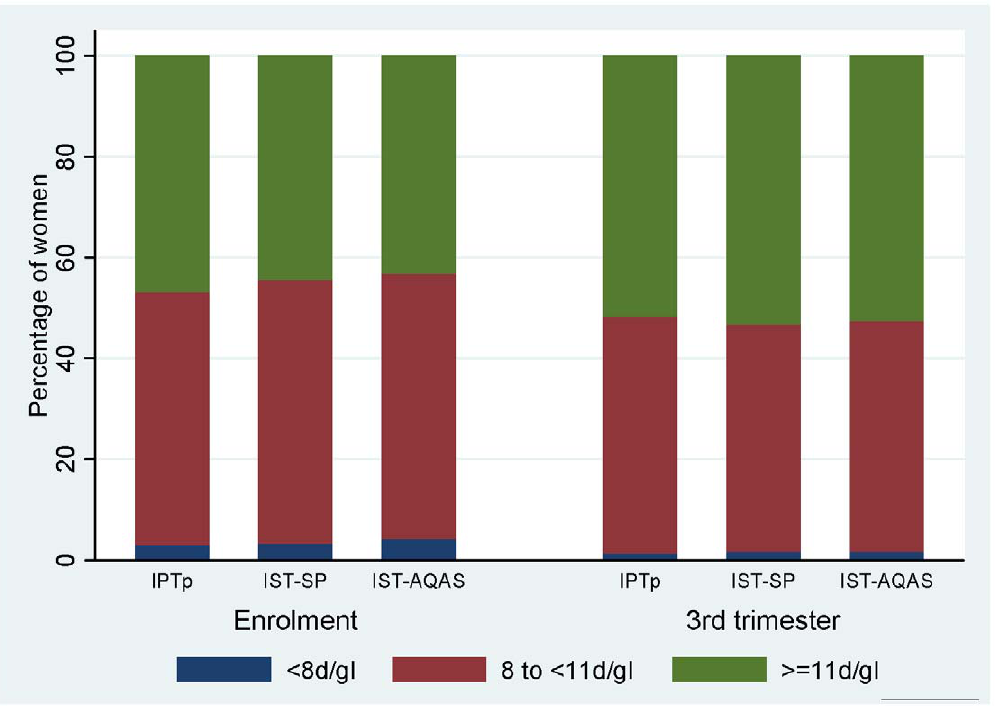
Figure 2. Mean change in Hb concentrations at 36 weeks gestation over baseline.